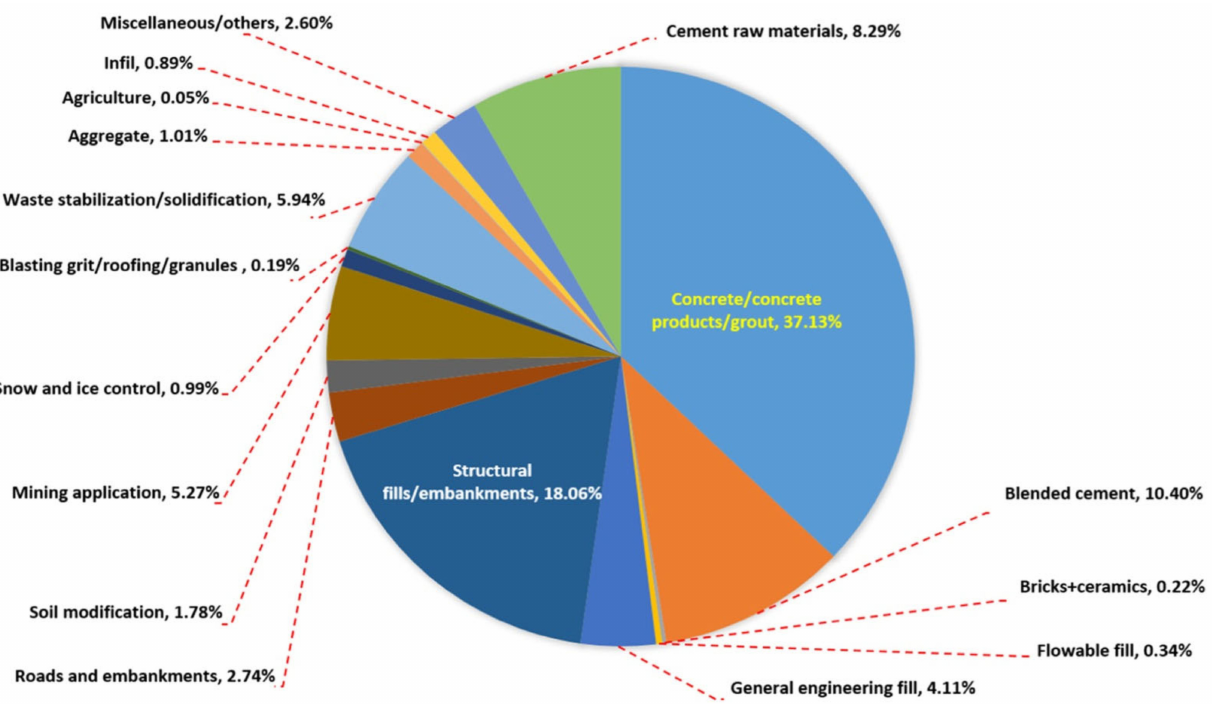
Figure 1. Potential percentage utilization of FA [23]. Reprinted with permission from Elsevier